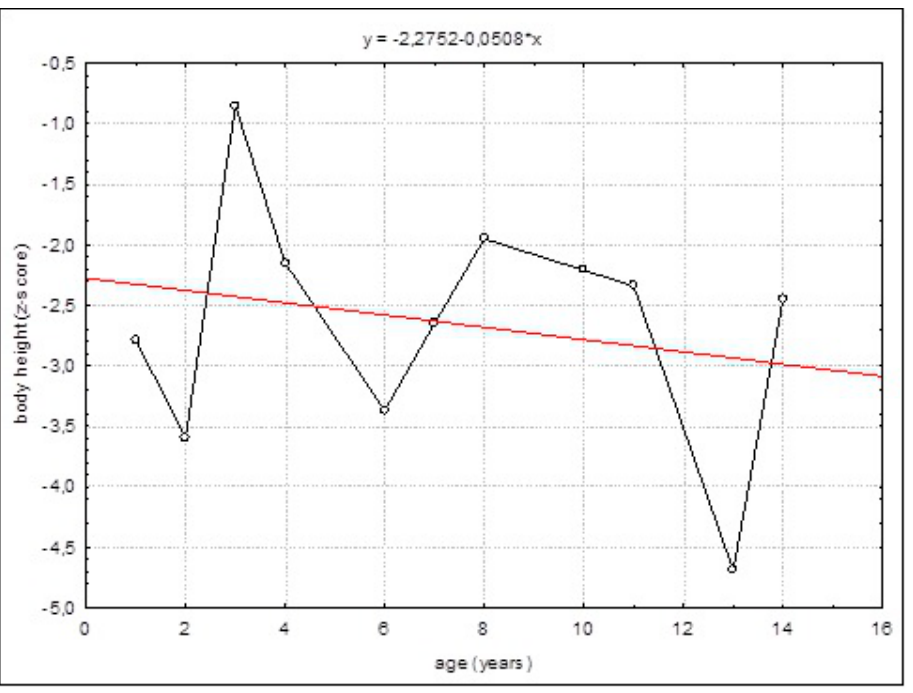
Figure 1. The straight-line regression of standardized body length/height against the adopted reference system.